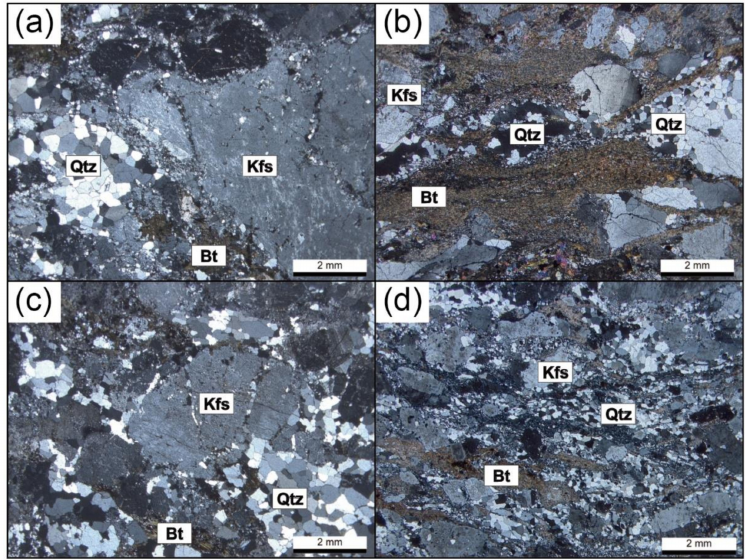
Figure 3. Photomicrograph of the AFG ( a , b ) and porphyritic alkali feldspar granite (PAFG; c , d ). Abbreviations: Kfs—K-feldspar, Bt—Biotite,